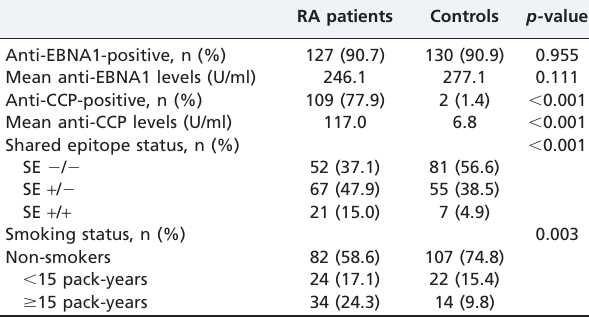
Table 2 - Comparative analysis of anti-EBNA-1, anti-CCP, SE status, and smoking status in RA patients and